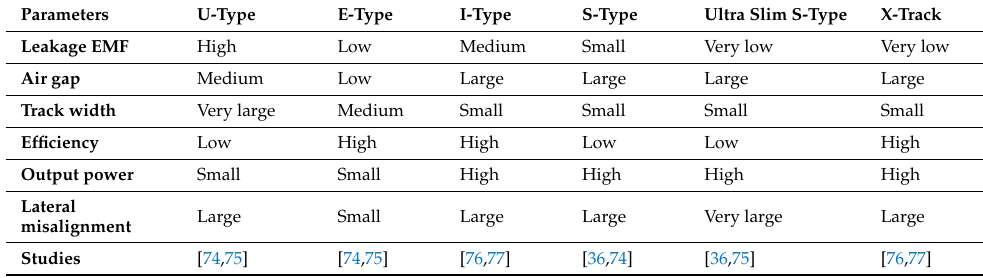
Table 2. Performance comparison of different single transmitting wire track used in DIPT